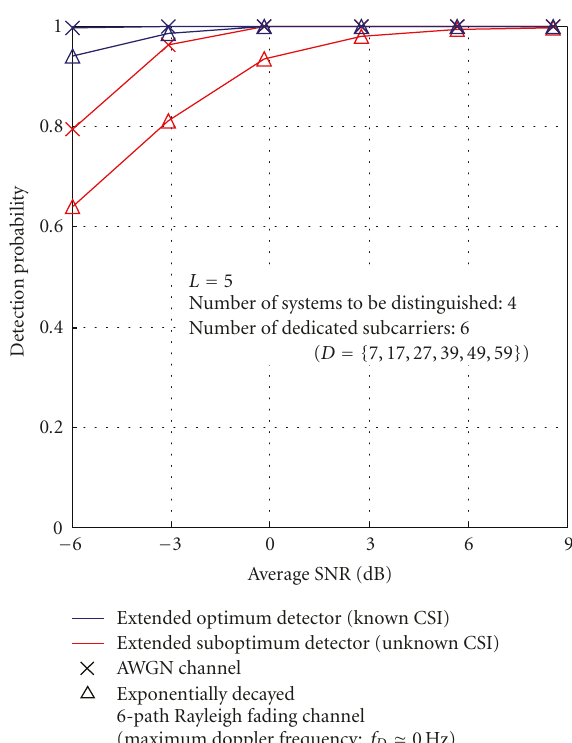
Figure 10: Performance for Method B: extended optimum and suboptimum detection with L = 5.